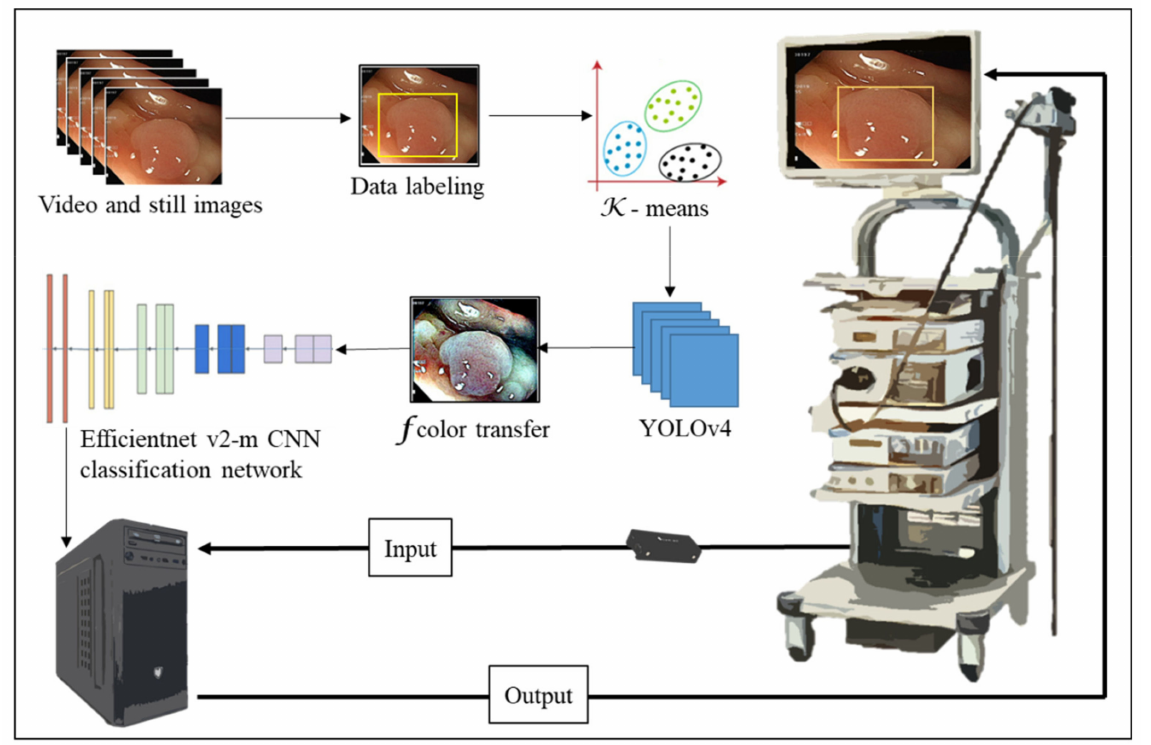
Figure 2. NBI simulated image enhancement system workflow. The polyp images are labeled and trained with YOLOv4 before color transfer to boost detection and classification